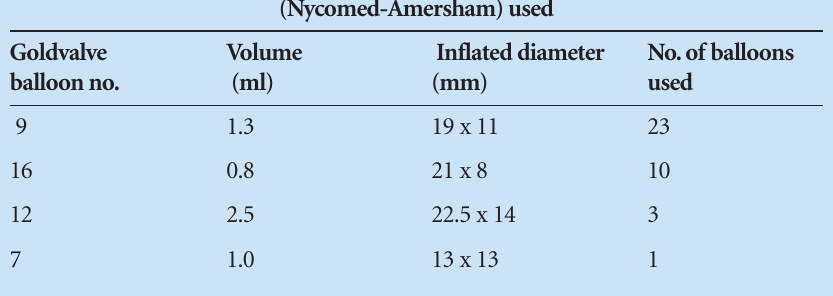
Table II. Sizes of the latex Goldvalve balloons (Nycomed-Amersham)